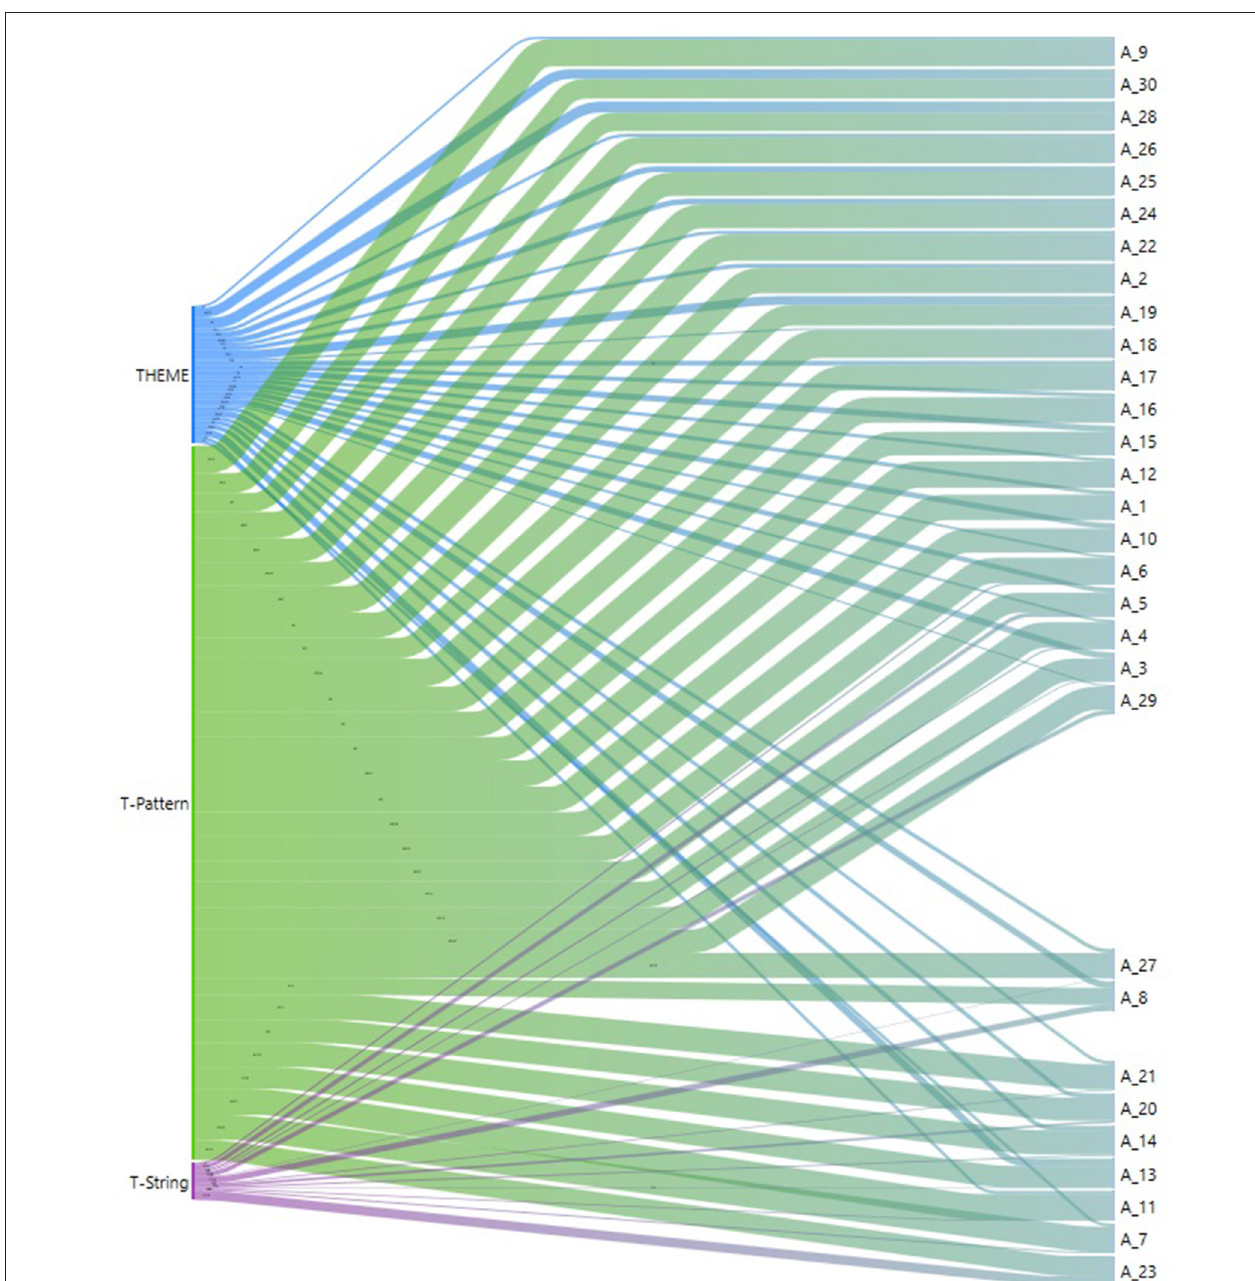
FIGURE 7 | Sankey diagram for keywords per document.